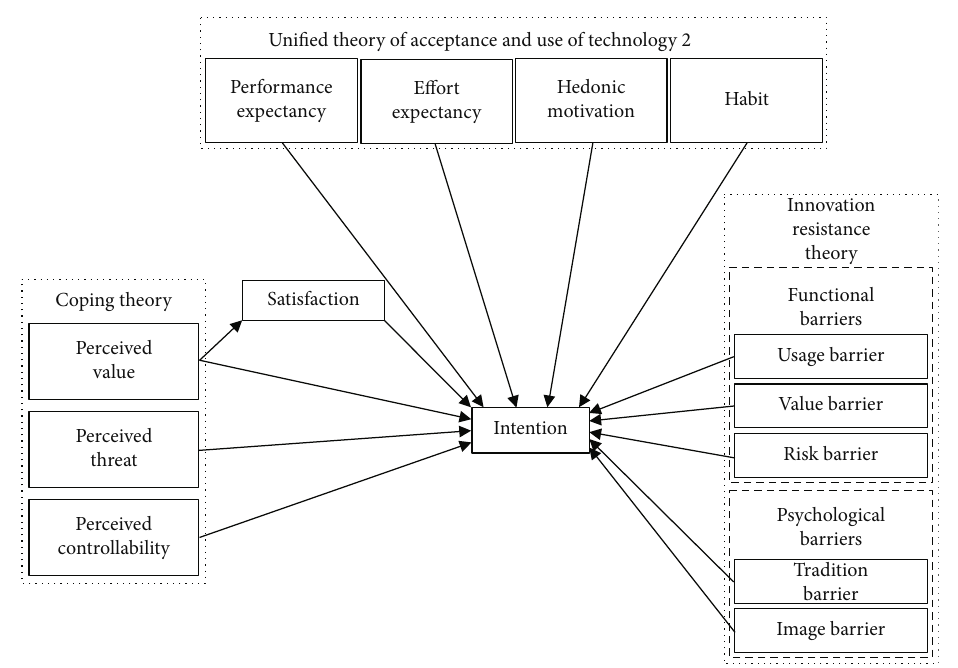
Figure 1: Conceptual framework.